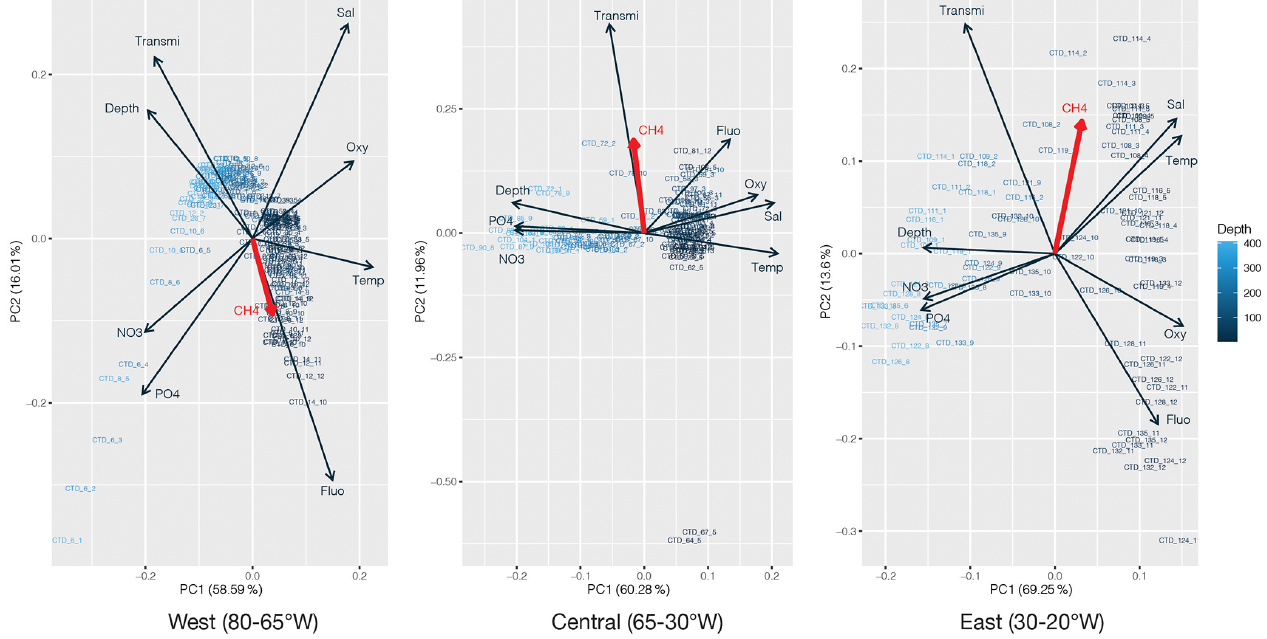
Figure 5. Principal component analysis of the regionalized dataset: west (80–65 ◦ W), central (65–30 ◦ W) and east (30–20 ◦ W). Numbers on the x and y axes indicate the factor loadings of each variable of each principal component (PC). The percentages show the explained variability in the dataset by each PC. CH 4 is highlighted in red.